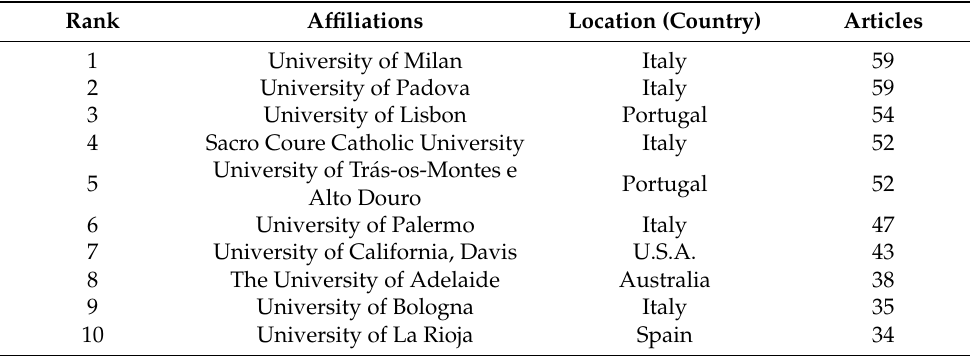
Table 7. Ranking of the Top-10 most relevant